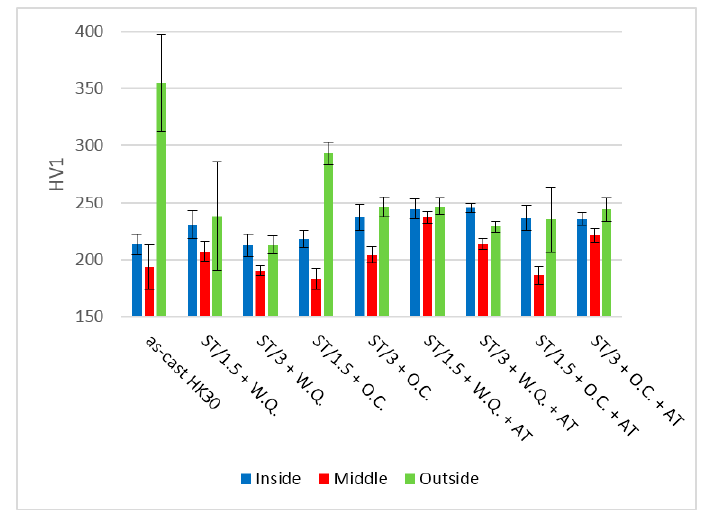
Figure 9. Micro-hardness measured on the matrix obtained for each heat treatment.